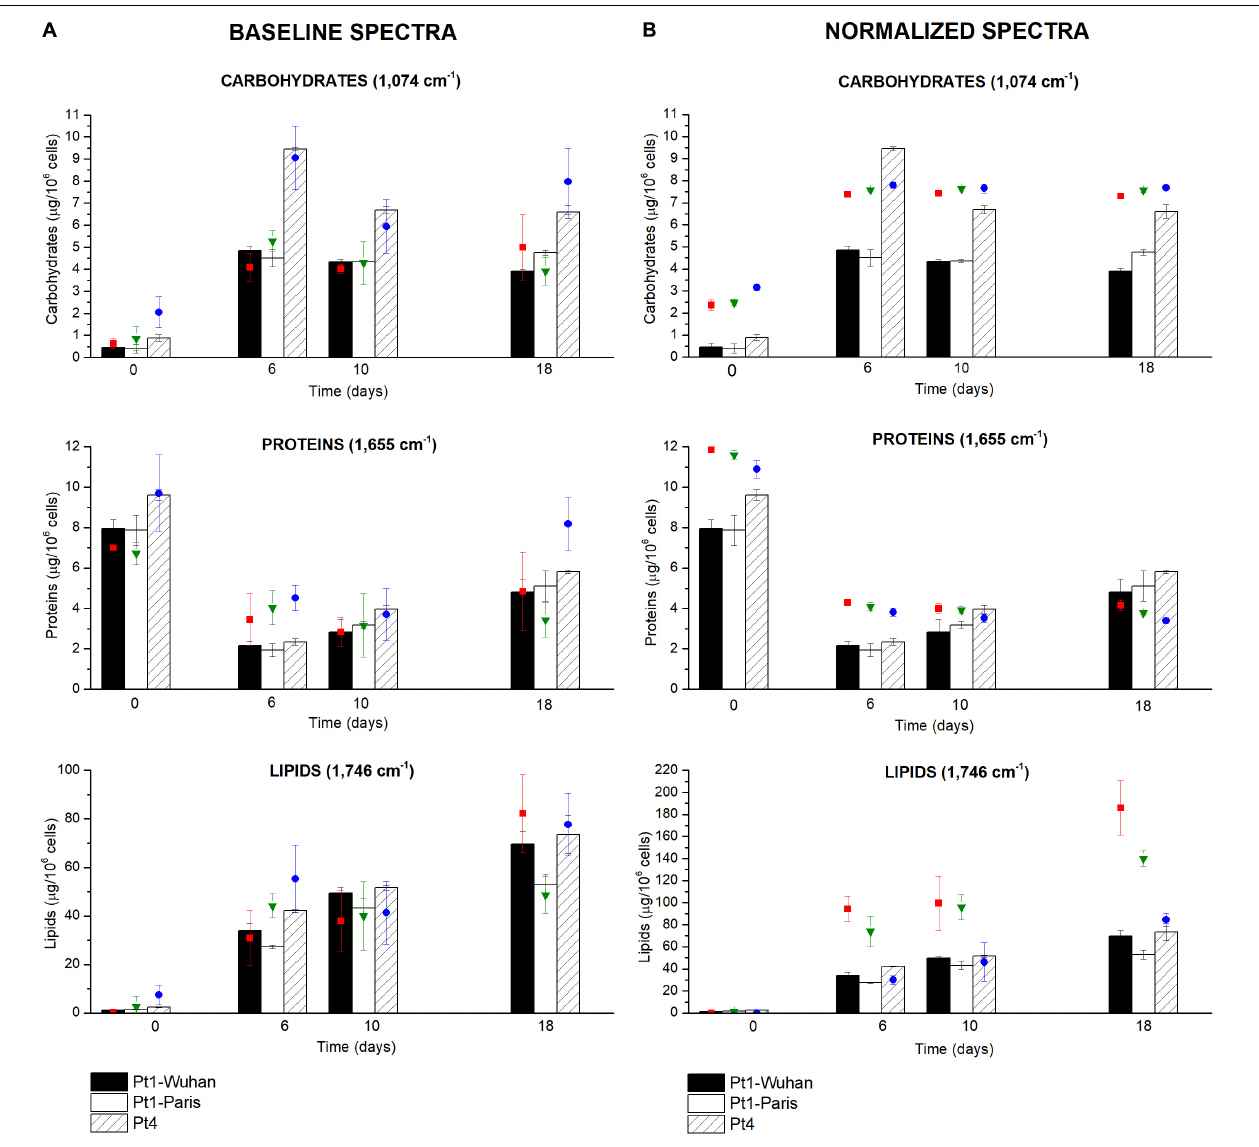
FIGURE 6 | Carbohydrates, proteins and lipids quantifications through the FTIR based methodology performed during a N-starvation of 18 days in the different ecotypes and strains of P. tricornutum . Quantifications performed with standard biochemical protocols are presented as histograms in the graph while quantifications using FTIR absorbance are represented as colored-dots (red square, green triangle, and blue dots), considering (A) baseline-corrected spectra or (B) baseline and normalized-corrected spectra. FTIR quantifications are performed at 1,074 cm – 1 for carbohydrates, 1,655 cm – 1 for proteins, and 1,746 cm – 1 for lipids.